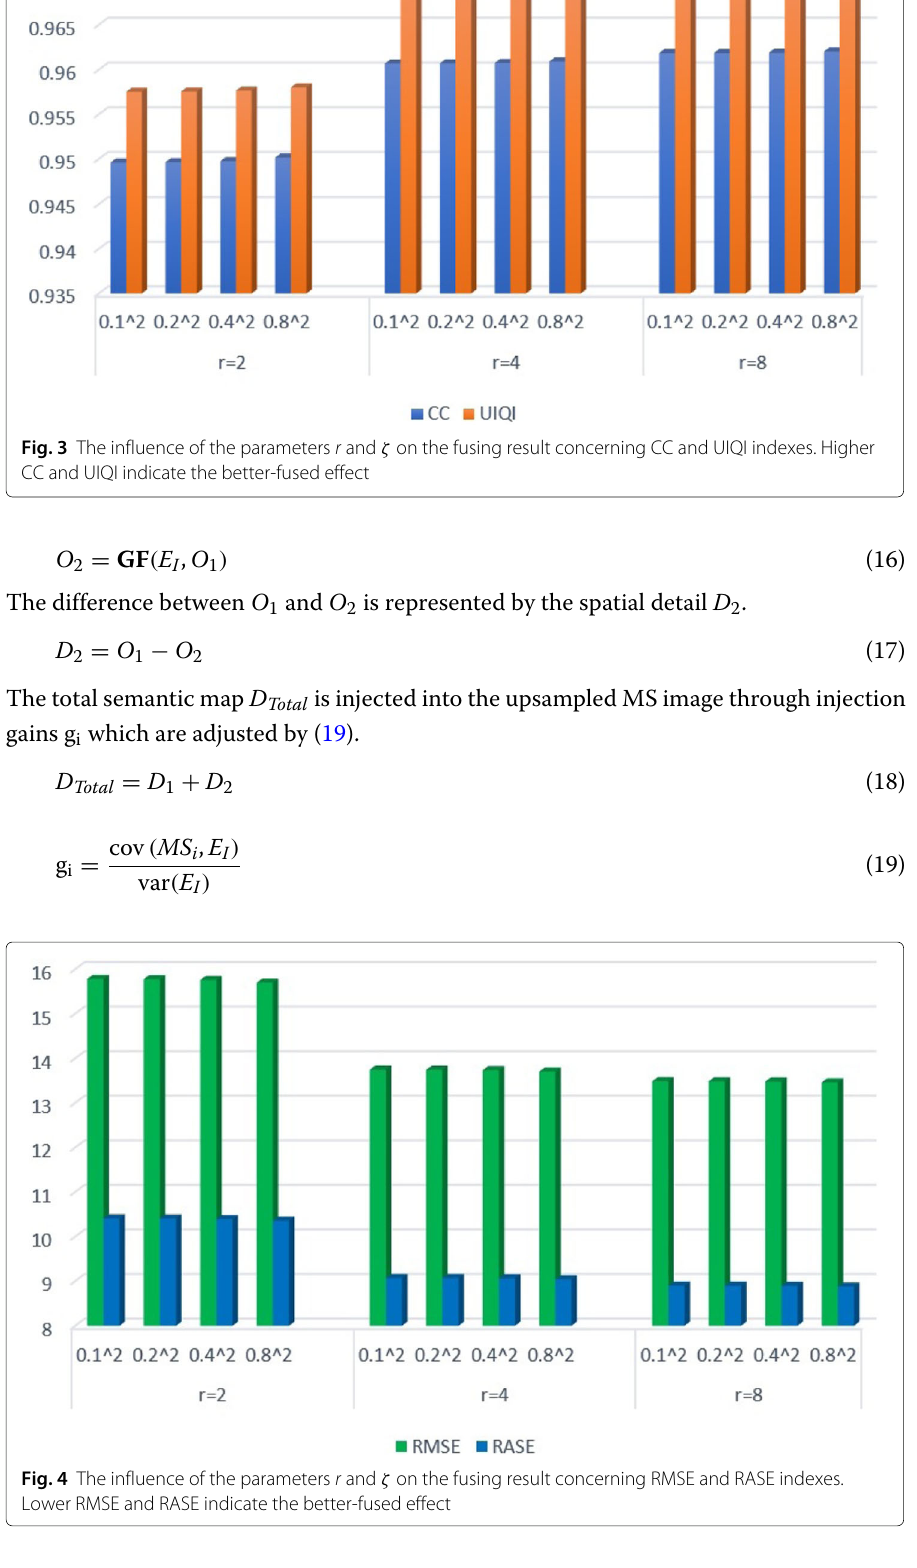
Fig. 4 The influence of the parameters r and ζ on the fusing result concerning RMSE and RASE indexes. Lower RMSE and RASE indicate the better-fused